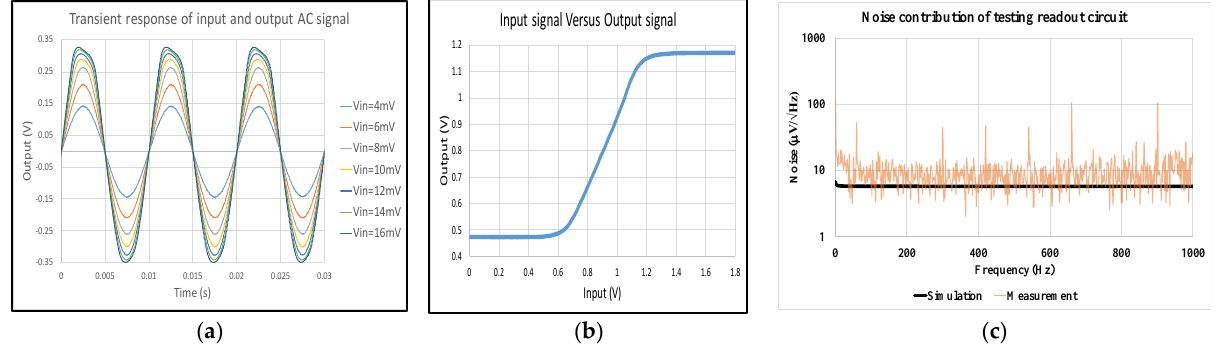
Figure 16. ( a ) Output waveforms corresponding to increasing input at 100 Hz; ( b ) input versus output signal of readout circuit; ( c ) noise contribution of testing readout circuit.